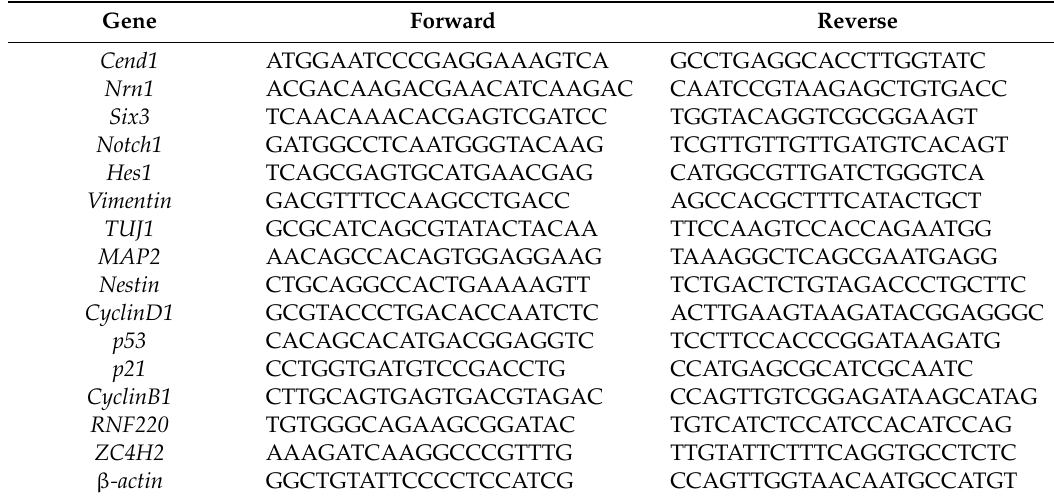
Table 1. Primer pairs used for